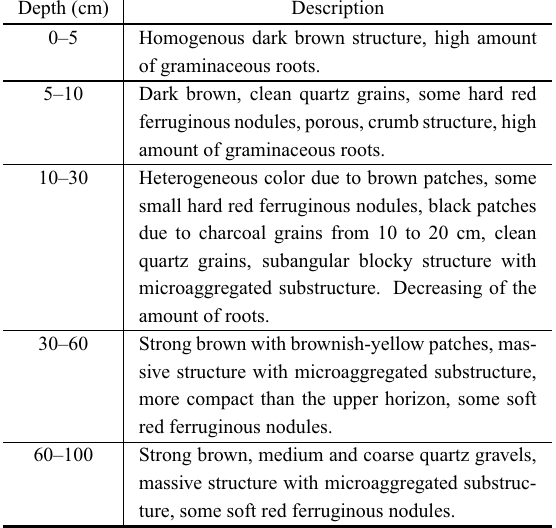
Morphological description of soil in PEFI sampling site.